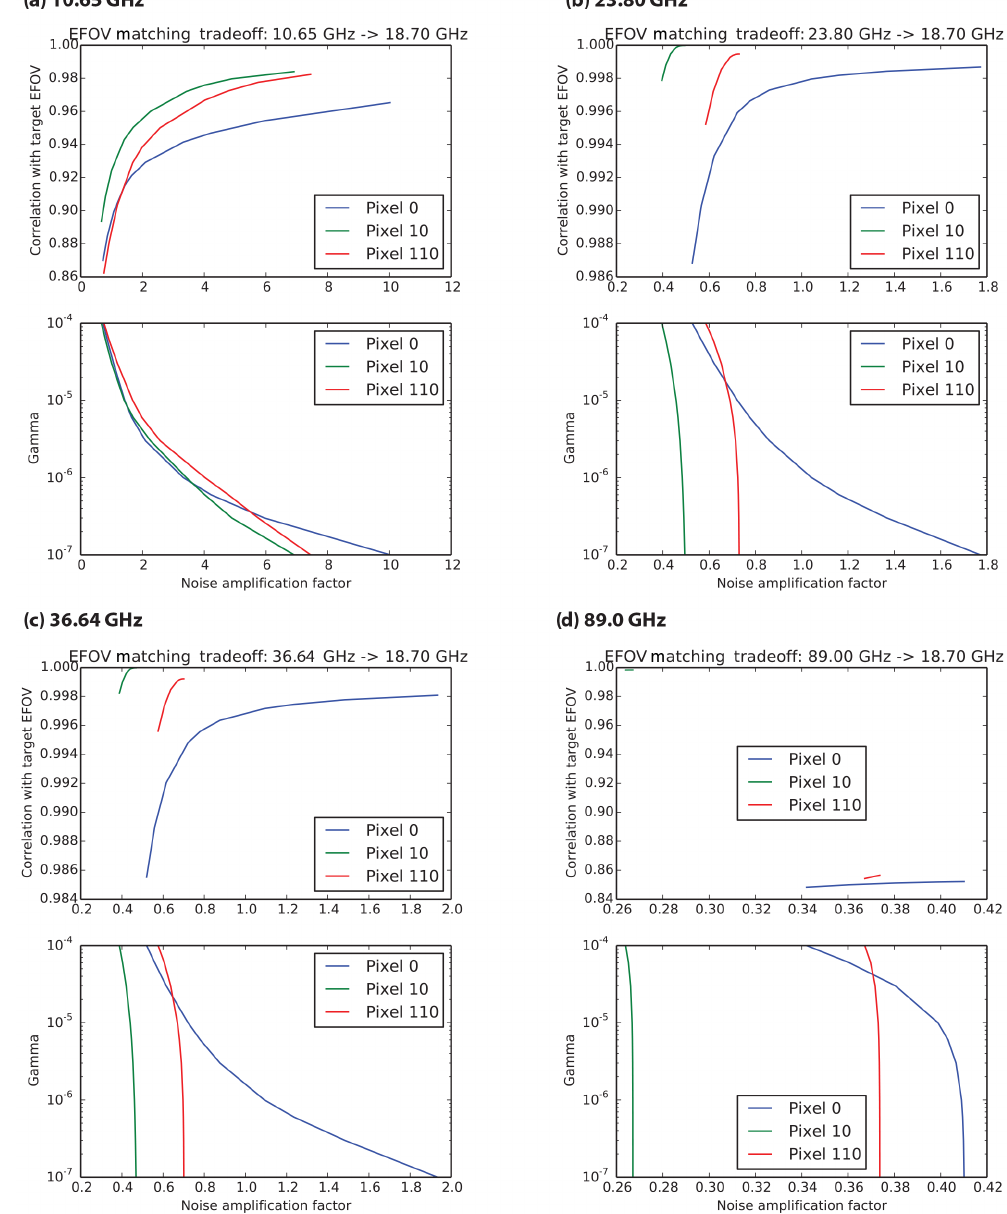
Figure 4. Relationship between noise factor, fit to the target EFOV, and the gamma parameter for the (a) 10.65, (b) 23.80, (c) 36.64, and (d) 89.0GHz channels. For each frequency, the top panel depicts the tradeoff between the fit (as indicated by the spatial correlation coefficient) and the noise factor; the bottom panel depicts the relationship between the gamma parameter and the noise factor. Pixel 0 is the first pixel in the scan, where the possibility for EFOV matching is partially limited by the absence of overlapping pixels beyond the edge of the swath. Pixel 10 is an interior pixel with comparatively high spatial sampling density, allowing for the best fit. Pixel 110 is at the center of the swath, where the sampling density is